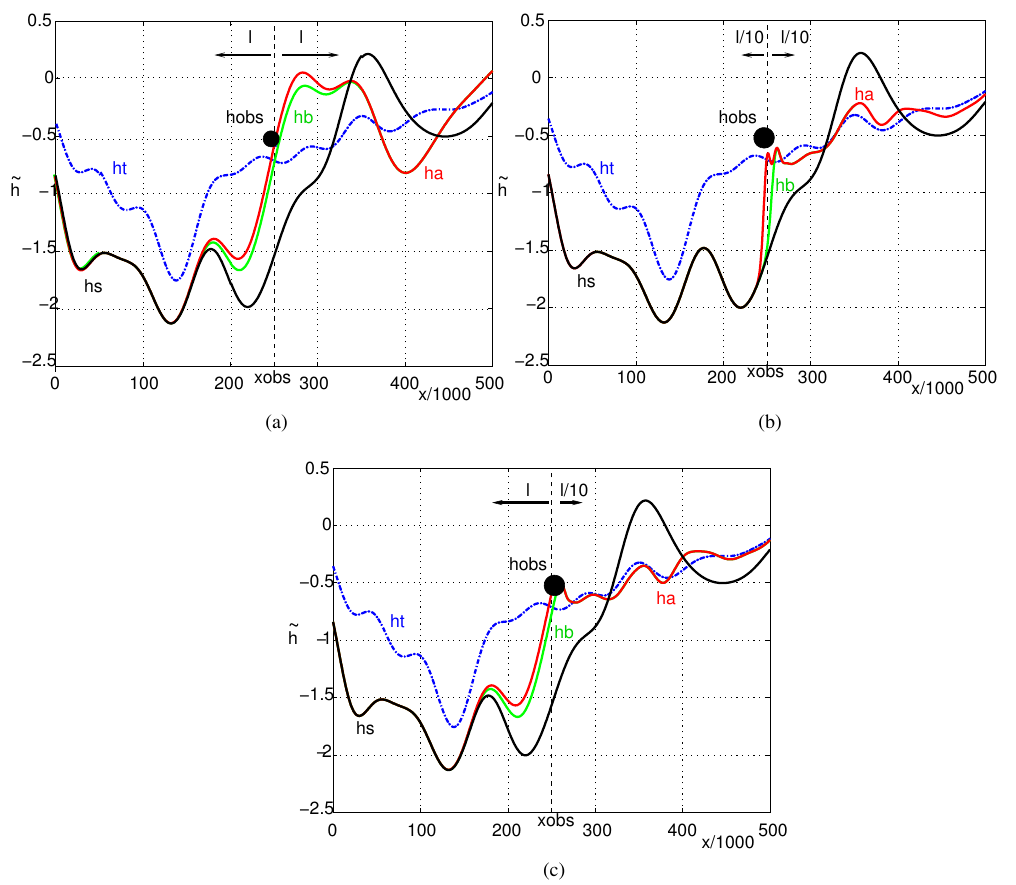
Fig. 5. Water level perturbation e h of the advection-diffusion model for the true simulation (dotted blue line), the free simulation (black solid line), the background simulation (green solid line) and the analysed simulation (red solid line) with (a) l − = l + = l(x obs ) , (b) l − = l + = l(x obs )/ 10, (c) l − = l(x obs ) and l + = l(x obs )/